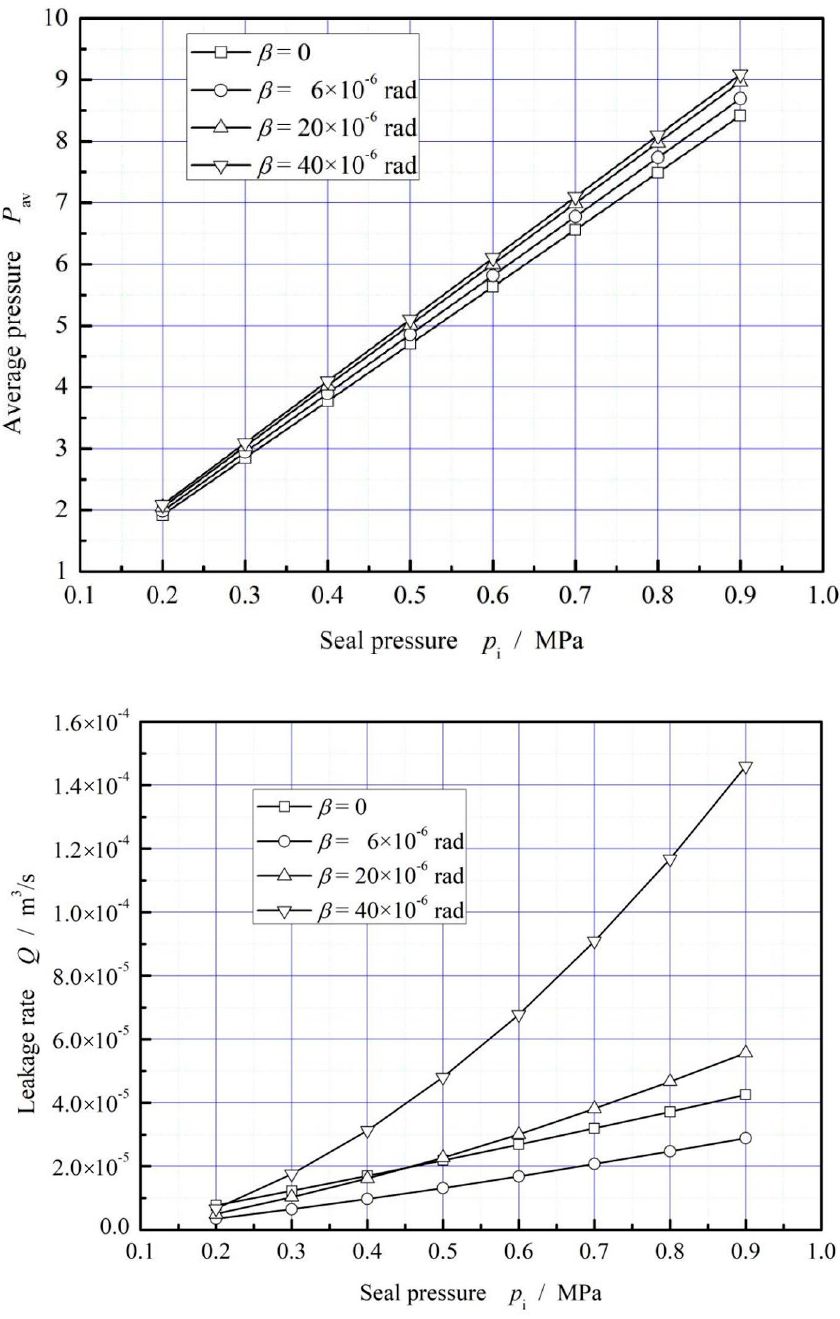
Figure 12. Influence of seal pressure on dimensionless mean pressure and leakage. ( ω = 3.0 × 10 4 r/min, T in = 580 K, T out = 380 K).